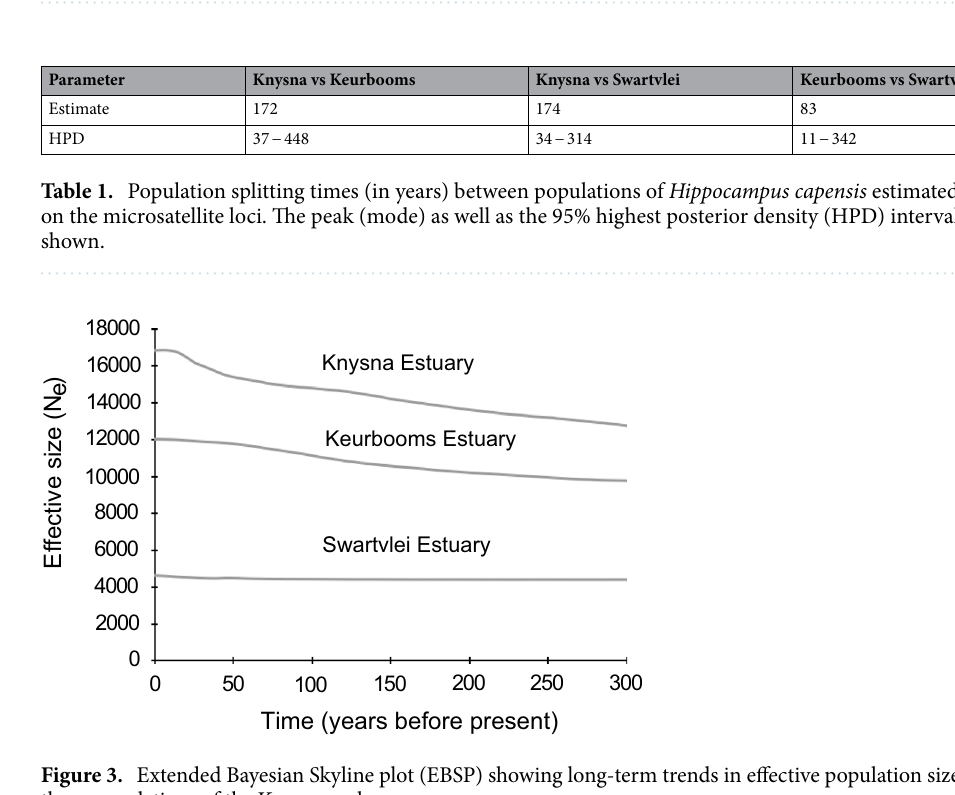
Figure 2. Maximum likelihood tree showing splits and gene flow between Knysna seahorse populations estimated for the microsatellite dataset using TreeMix. Arrows indicate the direction of gene flow, with migration weight indicated based on colour. The drift parameter along the x-axis gives a measure of variance in allele frequency change along each population branch.